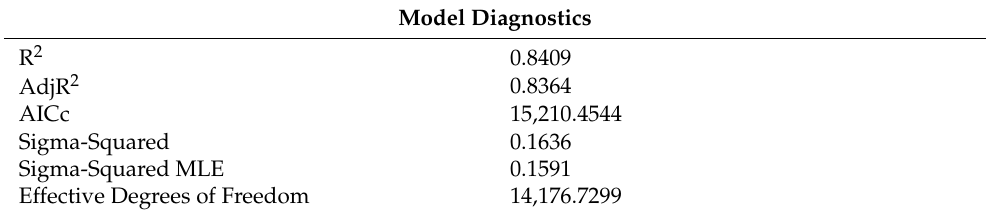
Figure 6. Left : feature importance; Right : correlation analysis heatmap. Table 3. Model diagnostics.